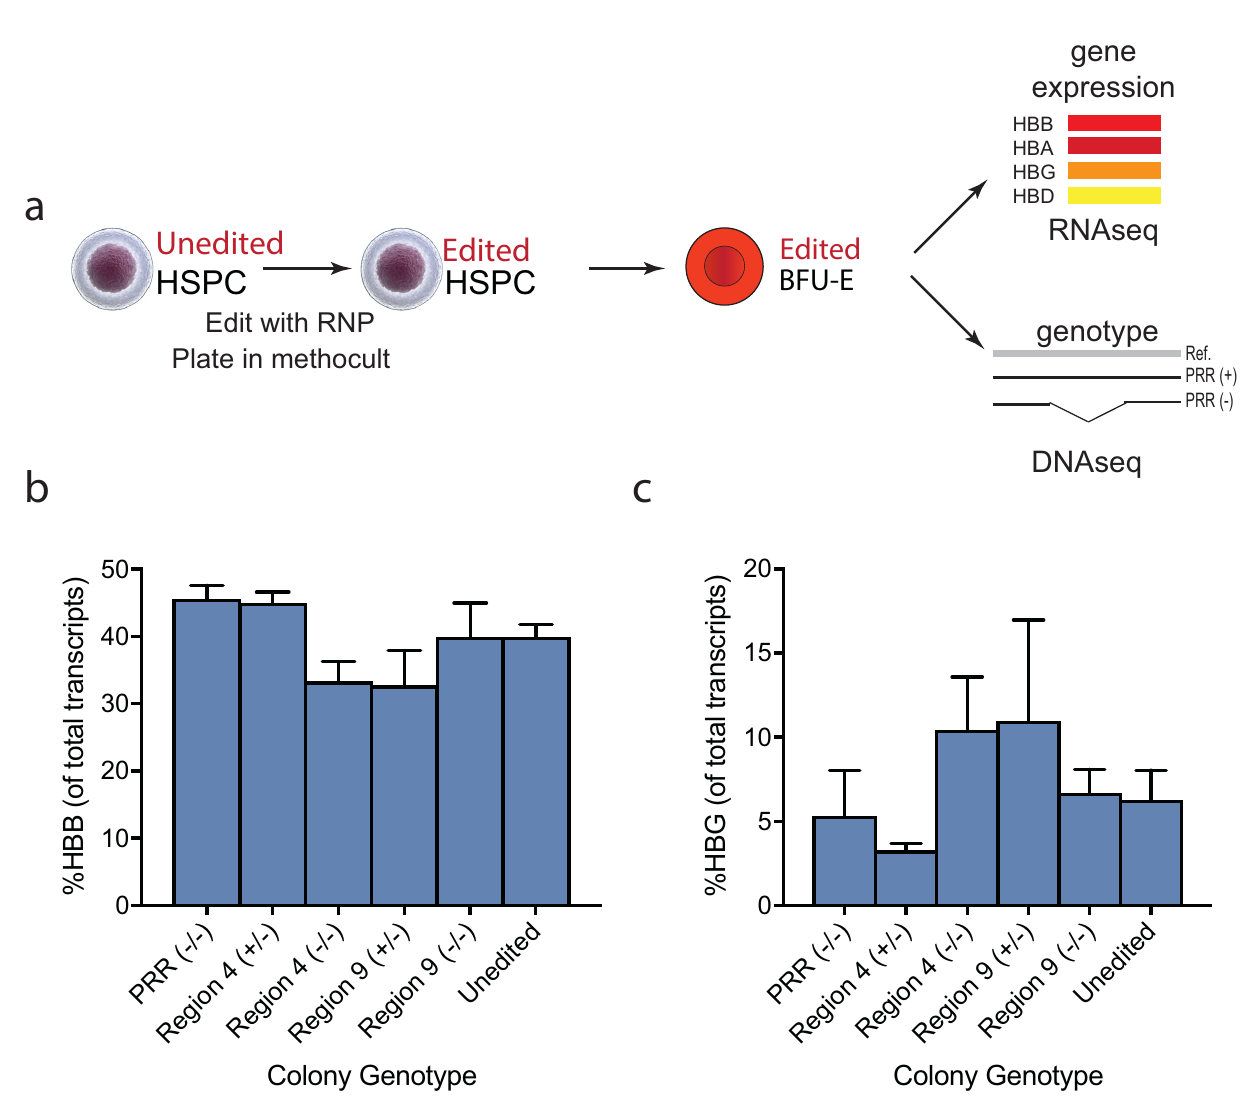
Fig 4. Genotype-phenotype relationships in clonal BFU-E colonies derived from edited hematopoietic stem/progenitor cells. A) Workflow depicting erythroid colony (BFU-E) formation genotype/phenotype assay using edited HSPC. HSPC were edited using RNPs targeting the desired region, plated in methocult, and colonies were grown for 14 days. Erythroid colonies were picked and genotyped by next-generation sequencing and phenotyped for their globin gene expression profile using RNA-seq. B) ß-globin (HBB) expression in erythroid colonies after gene editing, determined by RNA-seq. There was no statistically-significant difference in expression between each genotype of colony. C) γ -globin (HBG1+HBG2) expression in erythroid colonies after gene editing, determined by RNA-seq. Because of the high variation between colonies of the same genotype, there was no statistically-significant difference in expression between each genotype of colony. To control for effects of RNP electroporation, the unedited cells were electroporated with a non-targeting RNP against BFP.